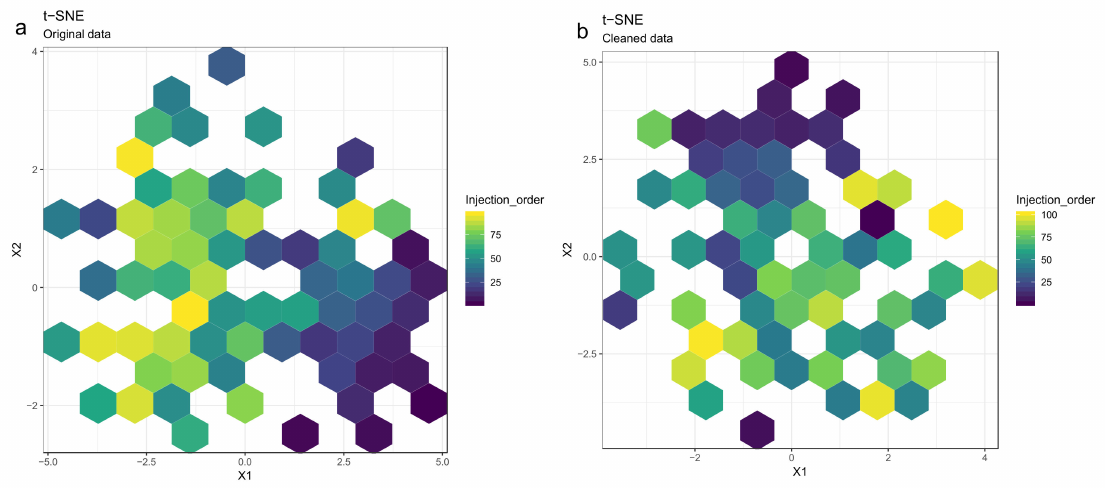
Figure 10. The hexbin plots show similar patterns as the scatterplots in Figure 9: The drift pattern in the injection order (the color trend) using the t-distributed stochastic neighbor embedding (t-SNE) method is visible before drift correction ( a ), whereas after drift correction ( b ), the samples are more randomly scattered. The color of each hexagon corresponds to the mean injection order of the data points in that